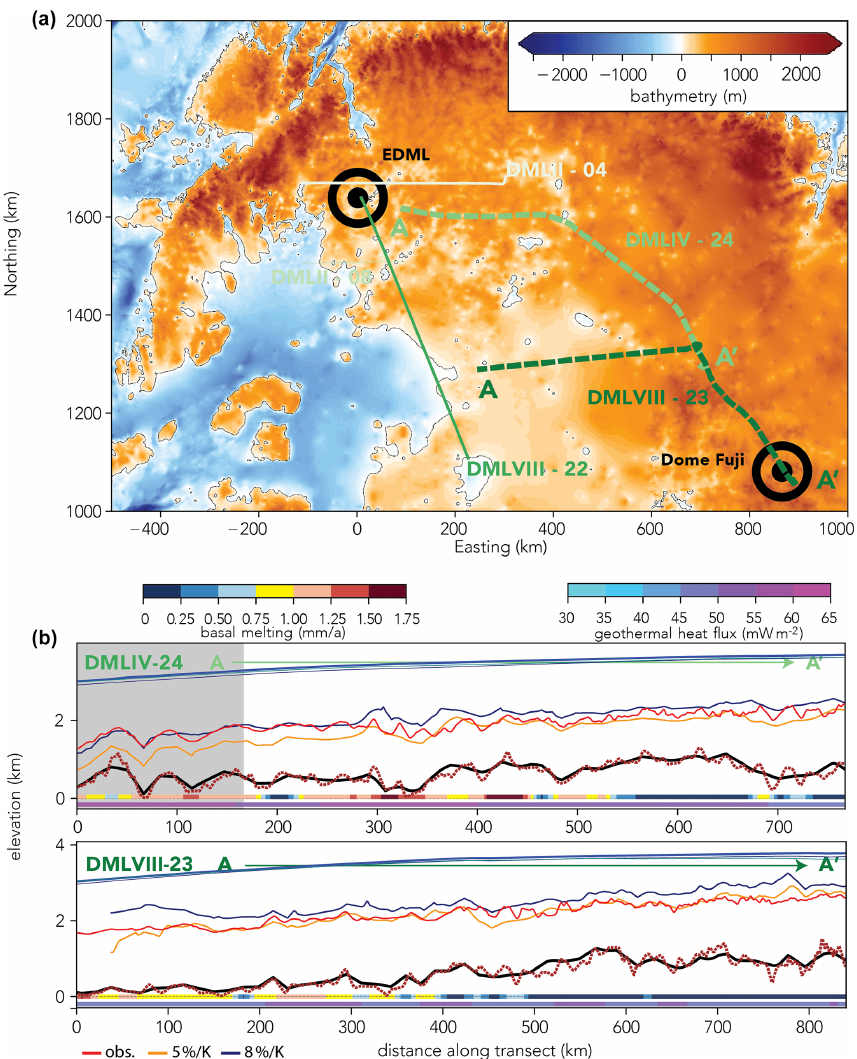
Figure 12. Overview of transect DML VIII-23 and IV-24. Panel (a) shows the bedrock elevation from Morlighem et al. (2020) at 1km resolution overlain by the DML transects in green and other radar transects analysed in this study (thin coloured lines). Panel (b) illustrates the ice surface, bedrock and isochrone elevation of the 74ka radar reflector (modelled: blue (8%K − 1 ), yellow (5%K − 1 ); observed: red). The model bedrock elevation is depicted in black, while the original radar data and the BedMachine Antarctica 1km grid are plotted in red. The coloured bars on the bottom of (b) depict the geothermal heat flux and the computed basal melt rate along the